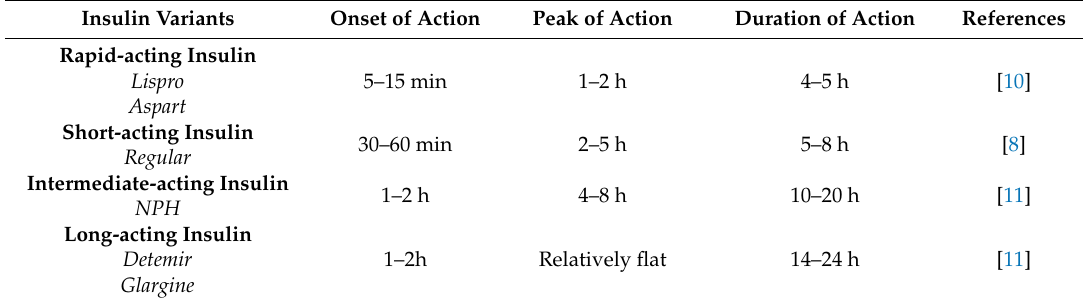
Table 1. Insulin